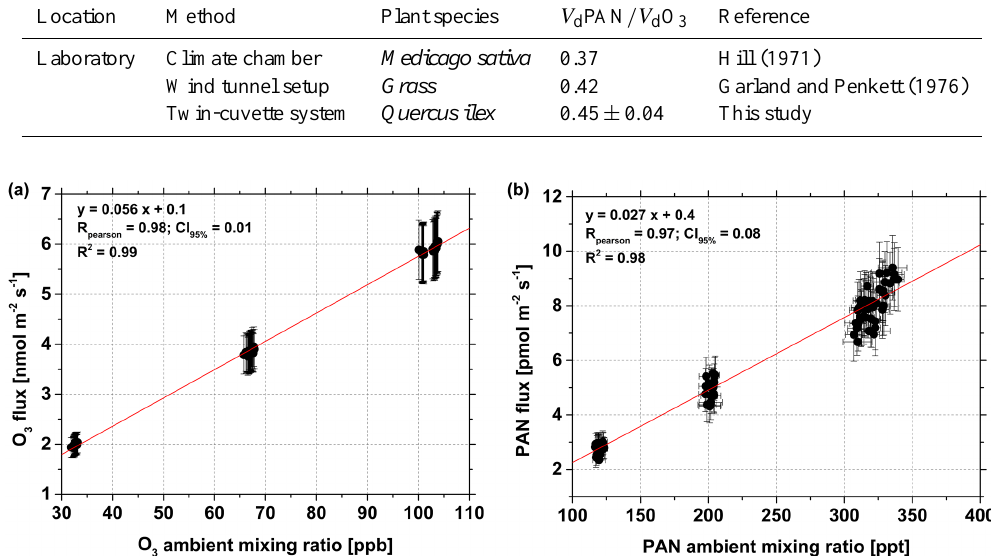
Figure 10. Behavior of O 3 and PAN flux with rising ambient mixing ratio. Both experiments were performed